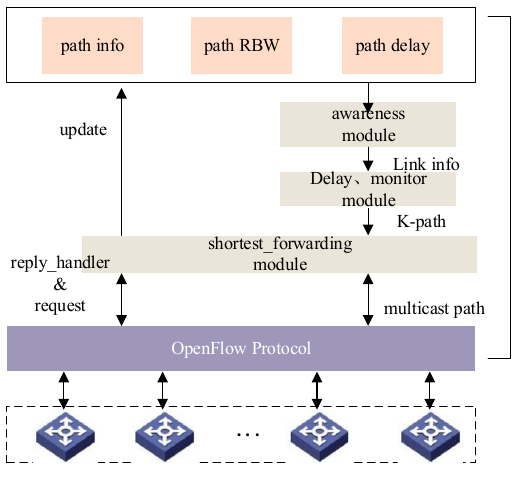
Figure 4. Ryu system